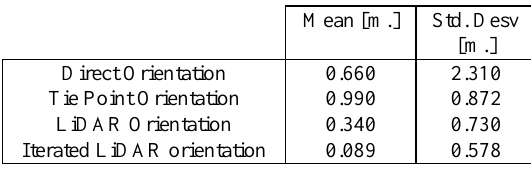
Figure 6: 2010 Orientation Evolution